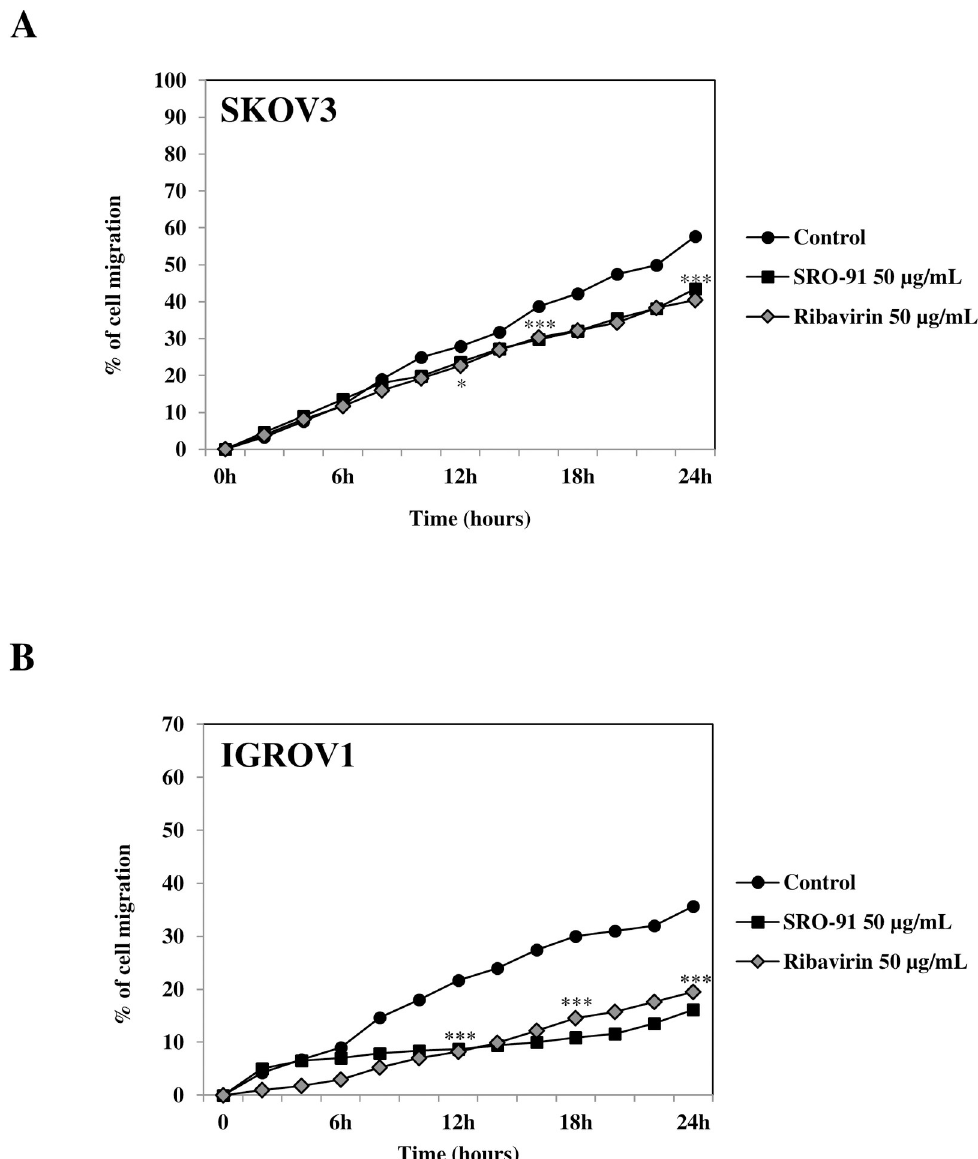
Fig 6. Cancer cells migratory properties after SRO-91 or ribavirin treatment or without treatment (control). ( A) SKOV3 or (B) IGROV1 cell migration was monitored by time-lapse microscopy over 24 h. Percentage of cell migration in three independent experiments was quantified using ImageJ software. The inhibition of cell migration by SRO-91 or RBV was significant from 12h in both cells lines. P-values were calculated by Paired one-way ANOVA test ( � P < 0.05, ��� P <